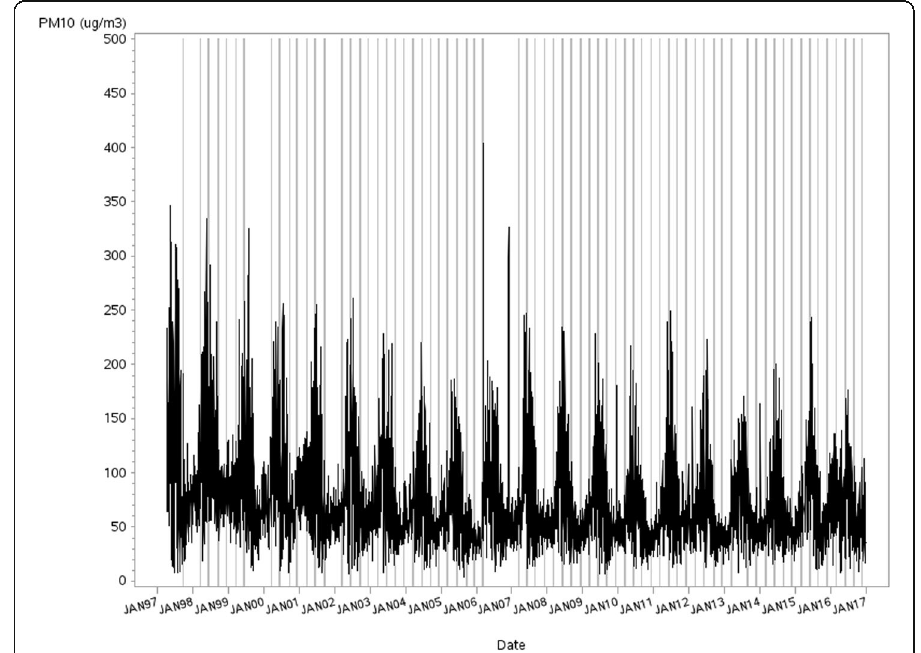
Fig. 1 PM 10 concentration in Santiago, Chile, 1997 – 2016. Notes: PM10 in microgrammes per cubic metre. Shaded area corresponds to the week prior to the employment survey reference week. Source: Own elaboration from SINCA, Pudahuel monitoring